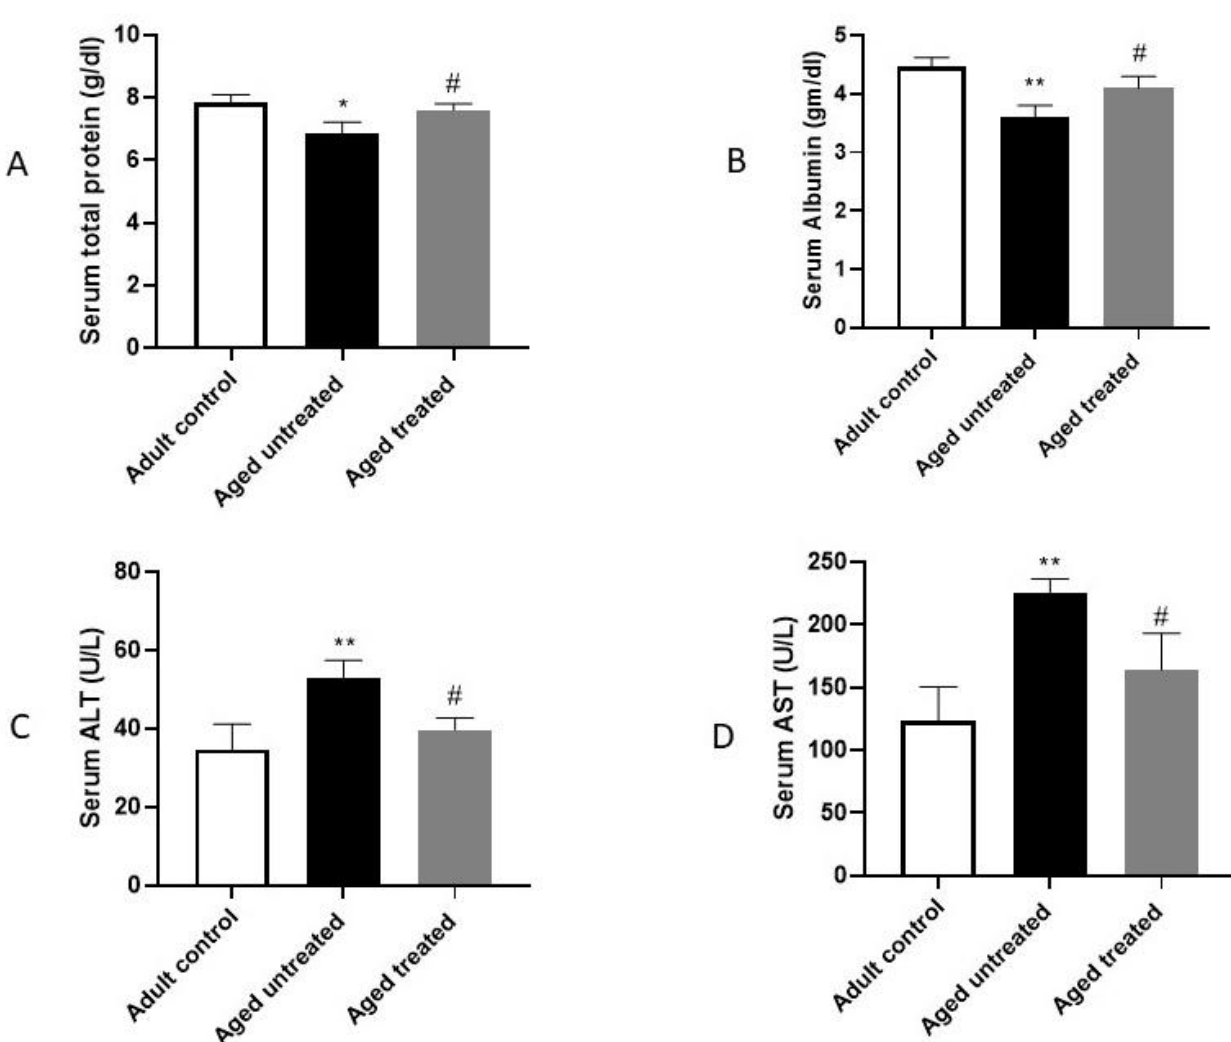
Figure 1. Effect of VK2 administration on liver function tests. ( A ) Serum total protein, ( B ) Serum Albumin, ( C ) Serum alanine aminotransferase (ALT) and ( D ) Serum aspartate aminotransferase (AST). Values are expressed as the mean ± SE, n = 6. * p < 0.05 and ** p < 0.01 compared to the Adult control group. # p < 0.05 compared to the Aged untreated group.